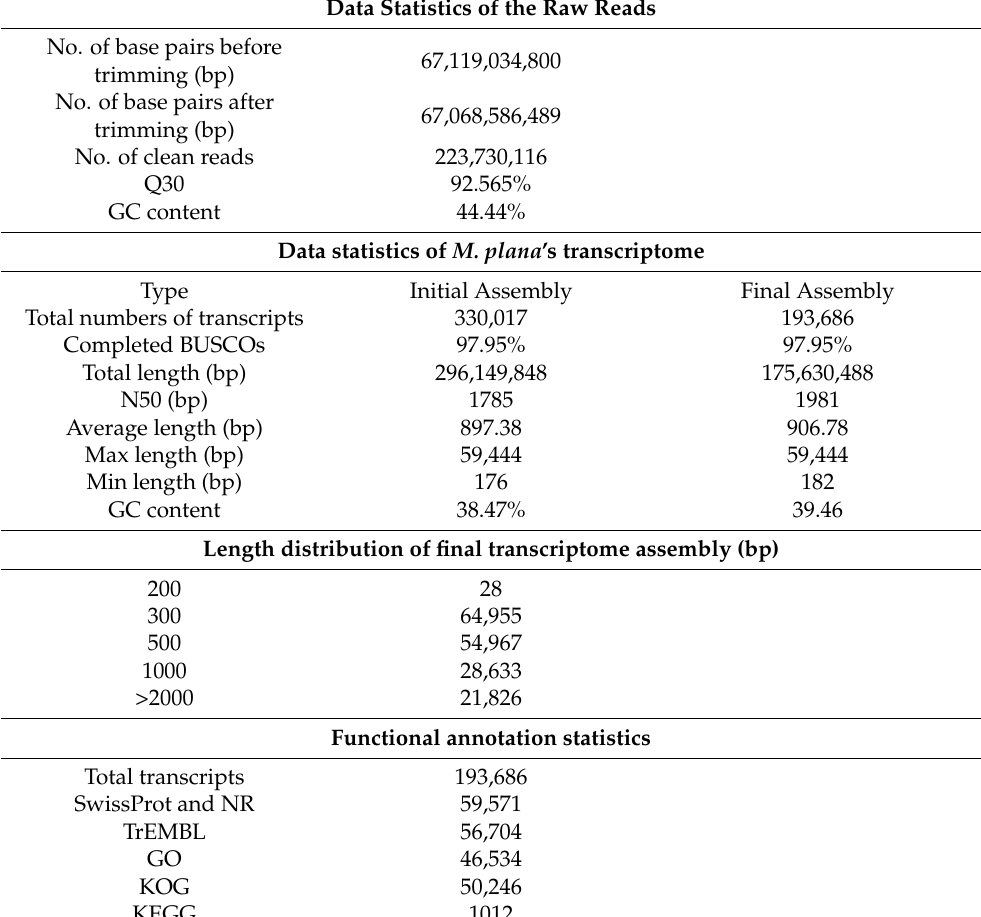
Table 1. Data statistics of the raw reads, transcriptome assembly and functional annotation of M. plana . Data Statistics of the Raw